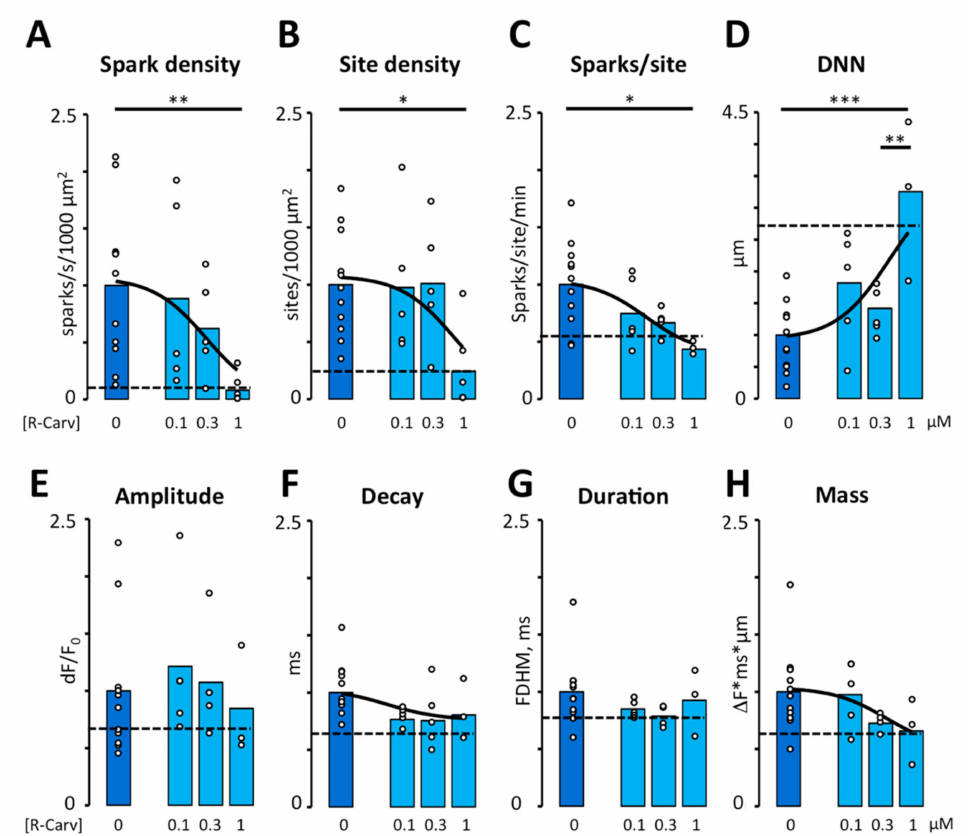
Figure 3. Effect of R-Carvedilol on calcium spark frequency and properties. Calcium spark frequency and properties were recorded in myocytes after addition of Feno and increasing doses of R-Carv (given below bars). ( A ) Spark density. ( B ) Spark site density. ( C ) Spark frequency per site. p -values in ( A – C ) were obtained using Kruskal–Wallis test followed by Bonferroni-adjusted multiple comparisons. ( D ) Distance to nearest neighbor (DNN). ( E ) Spark amplitude. ( F ) Decay time constant. ( G ) Full duration at half maximum (FDHM). ( H ) Spark mass. Data are from 45 cells/11 patients. p -values in ( D – H ) were obtained using ANOVA test followed by Tukey’s multiple comparisons test. Statistically significant differences between pairs of bars are indicated with *: p < 0.05, **: p < 0.01; ***: p < 0.001. Solid lines represent fitting using a Hill equation. Dashed lines represent mean values recorded in control conditions before exposure to Feno. Circles in ( A – H ) correspond with the values of individual data